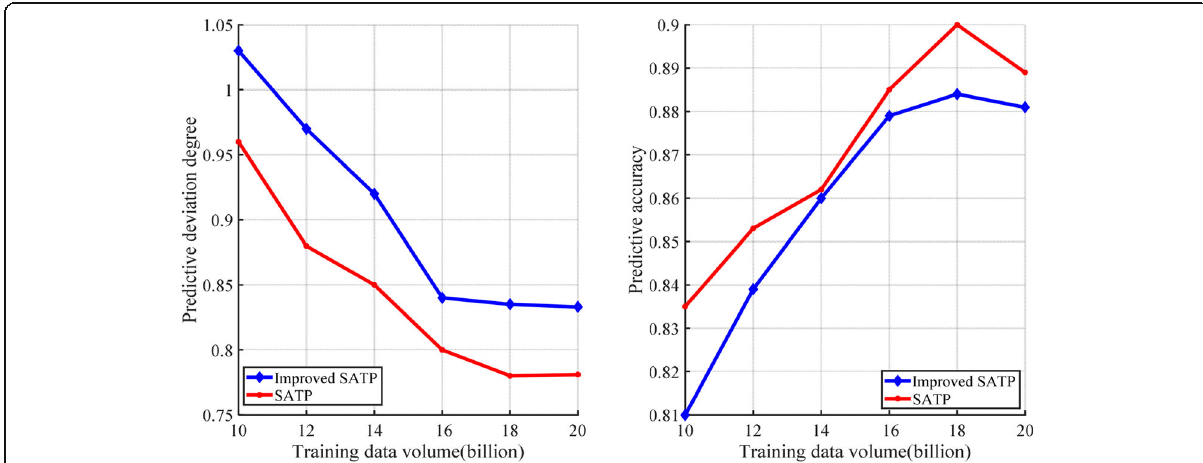
Fig. 8 Comparison of Accuracy of Original and Improved SATP Models